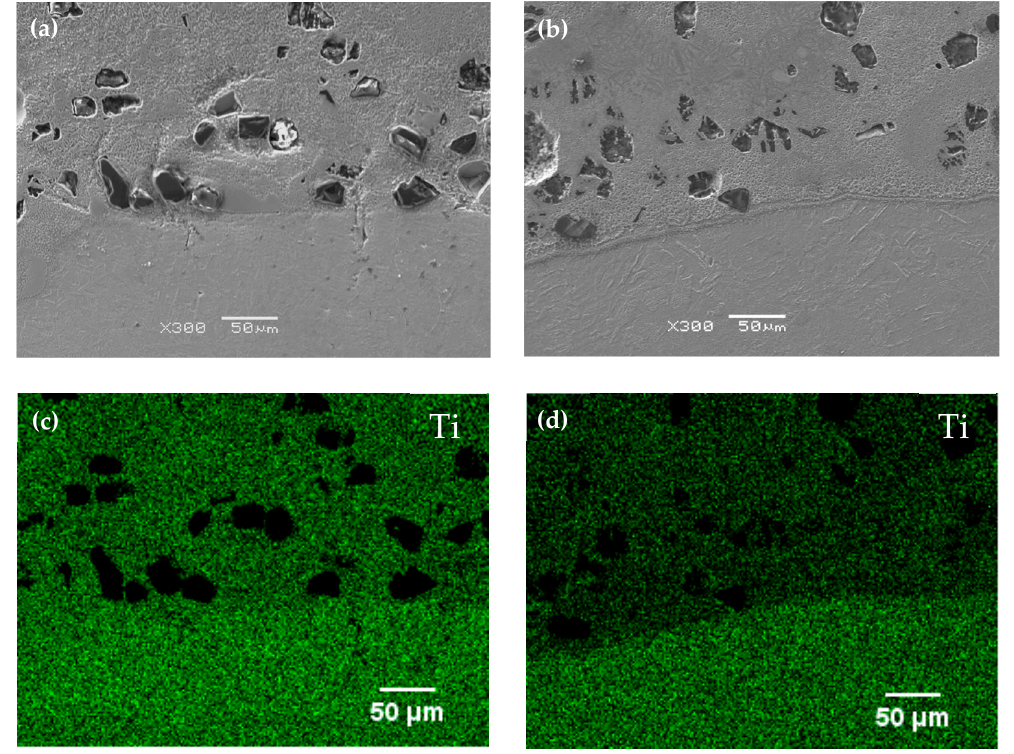
Figure 4. SEM and energy dispersive spectroscopy (EDS) mapping of interface between the coating and substrate: ( a ) cBN / Ti6Al4V coating; ( b ) NicBN / Ti6Al4V coating; ( c ) Ti element mapping of ( a ); and ( d ) Ti element mapping of ( b ).